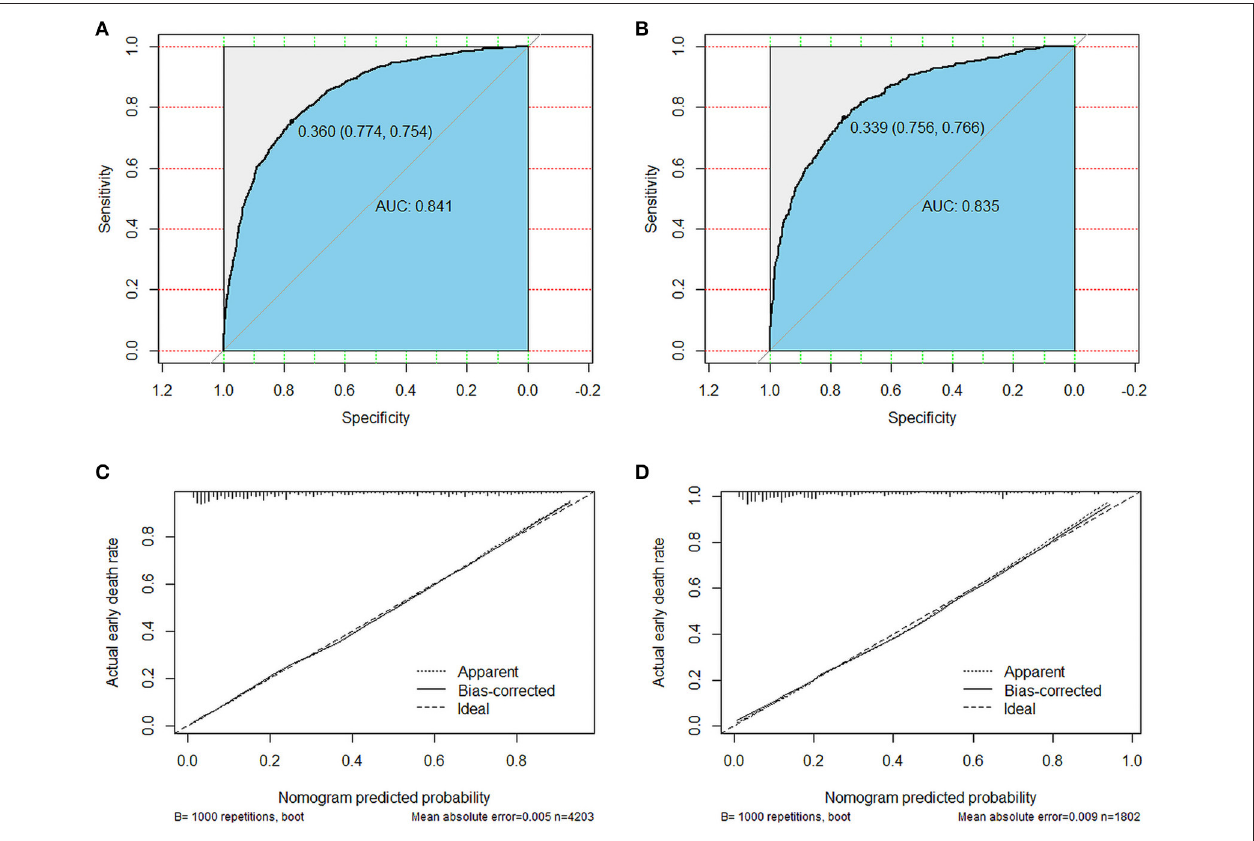
FIGURE 4 | ROC curves and calibration plots for the nomogram. The ROC curves for the nomogram in the training cohort (A) and the validation cohort (B) . The calibration plots for the nomogram in the training cohort (C) and the validation cohort (D)